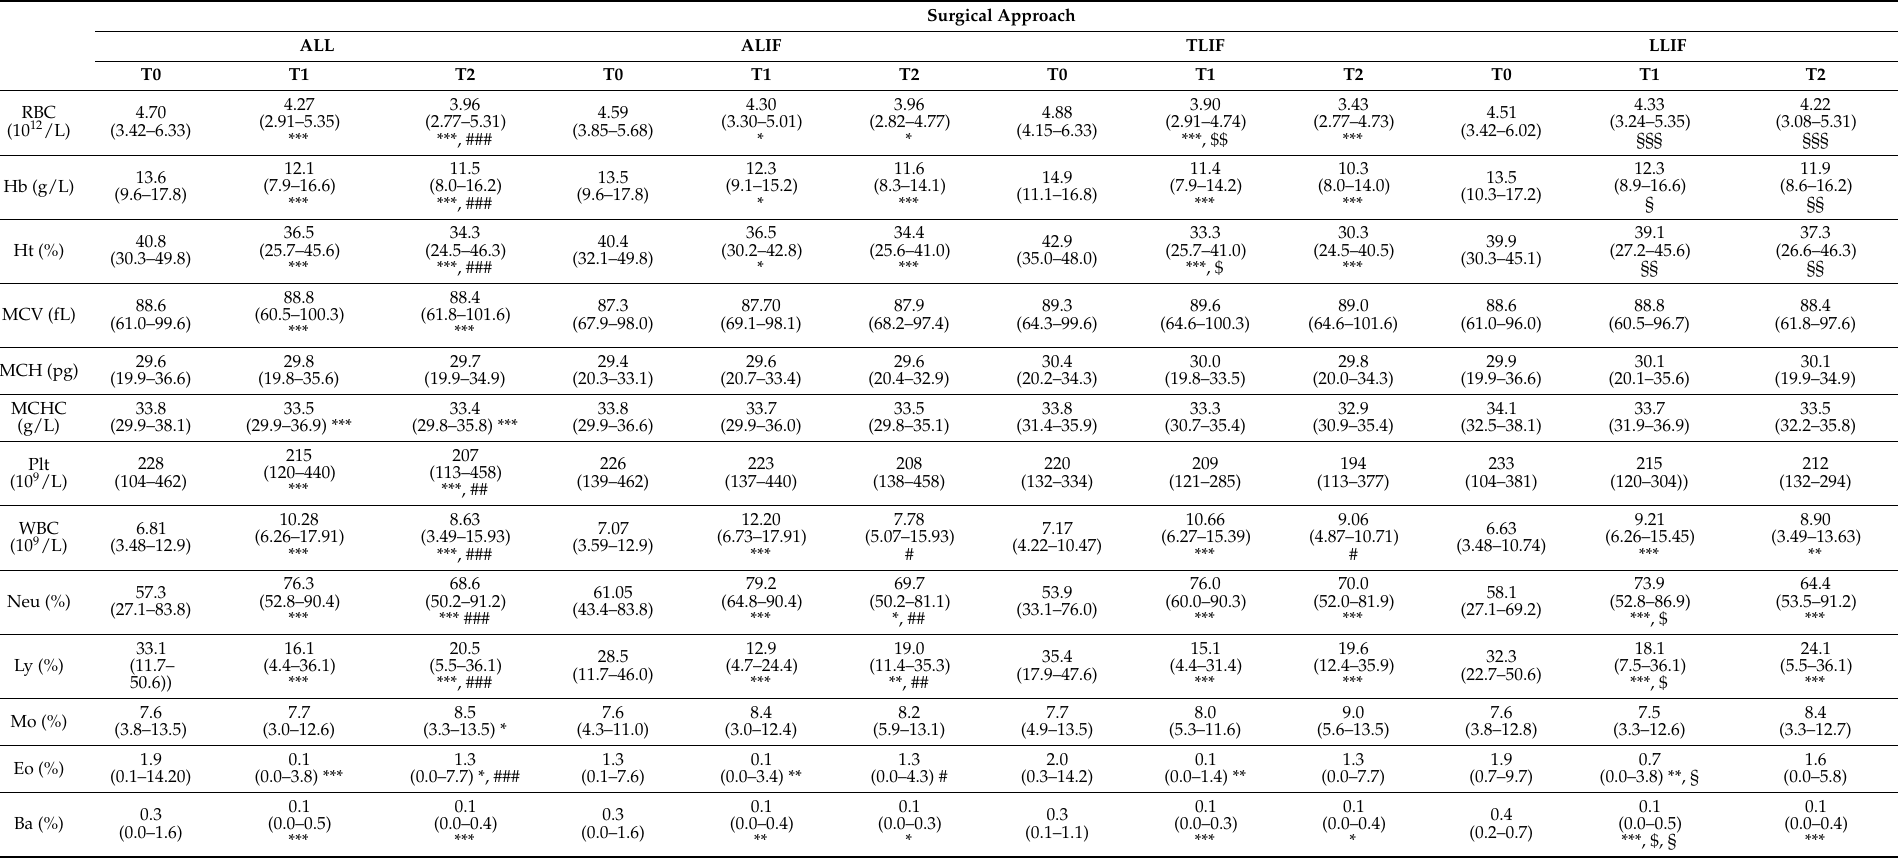
Table 1. Hematological profile over the peri-surgical